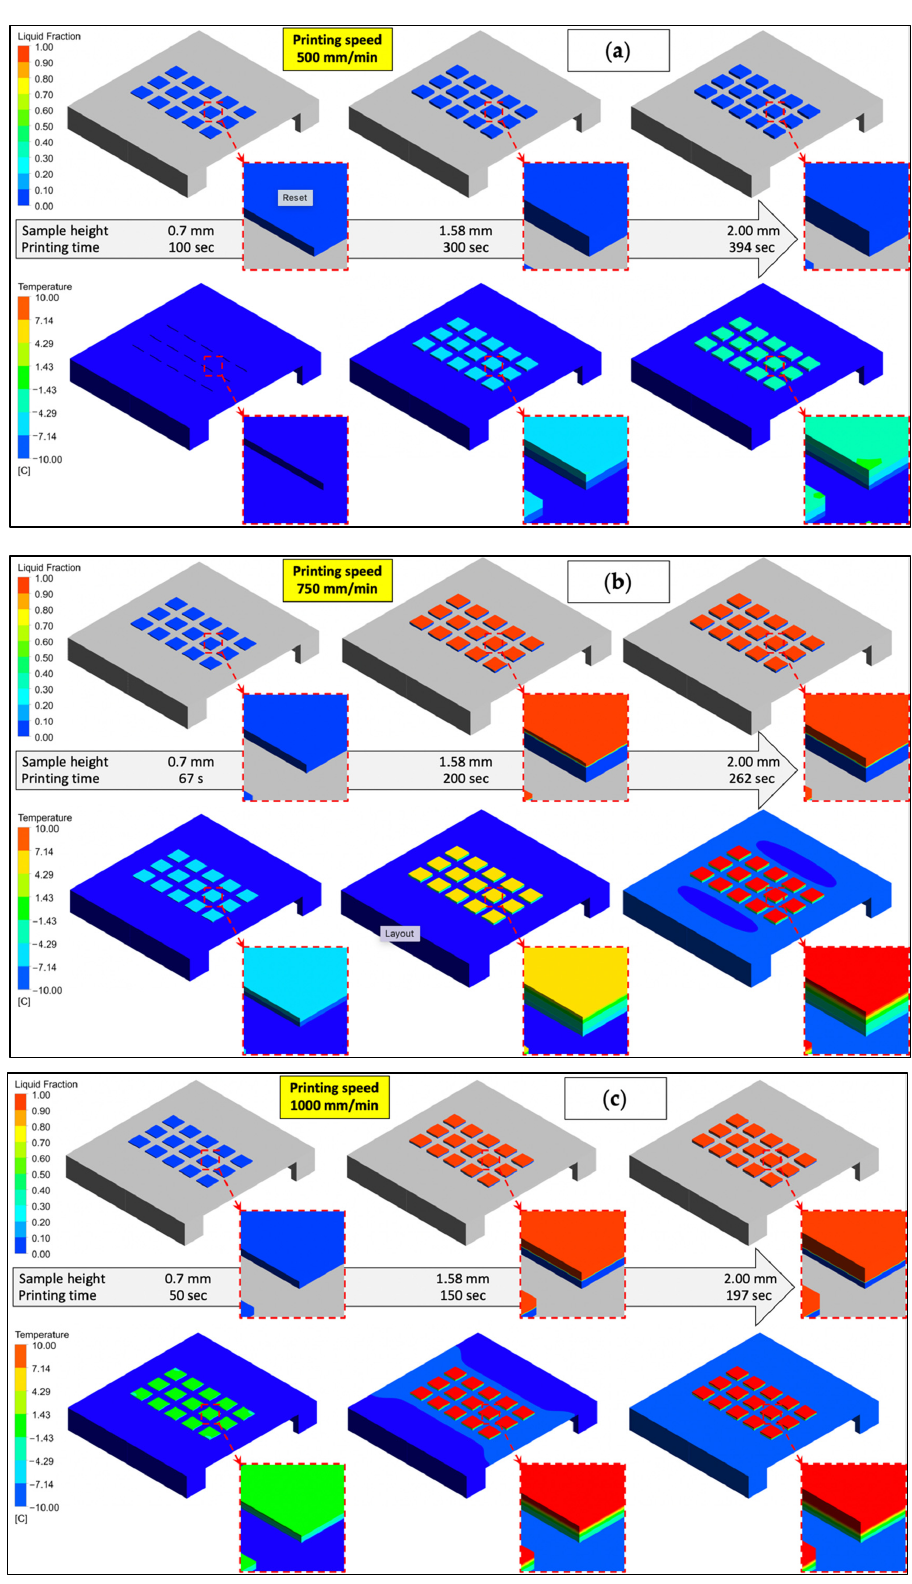
Figure 5. CFD results of liquid fraction and temperature on the sample during different printing speeds for three different printing speeds: ( a ) 500 mm/min, ( b ) 750 mm/min, and ( c ) 1000 mm/min. In all simulation cases the liquid fraction and temperature changed with the printing time of the sample (sample size was 10 × 10 mm and maximum sample height was 2 mm).